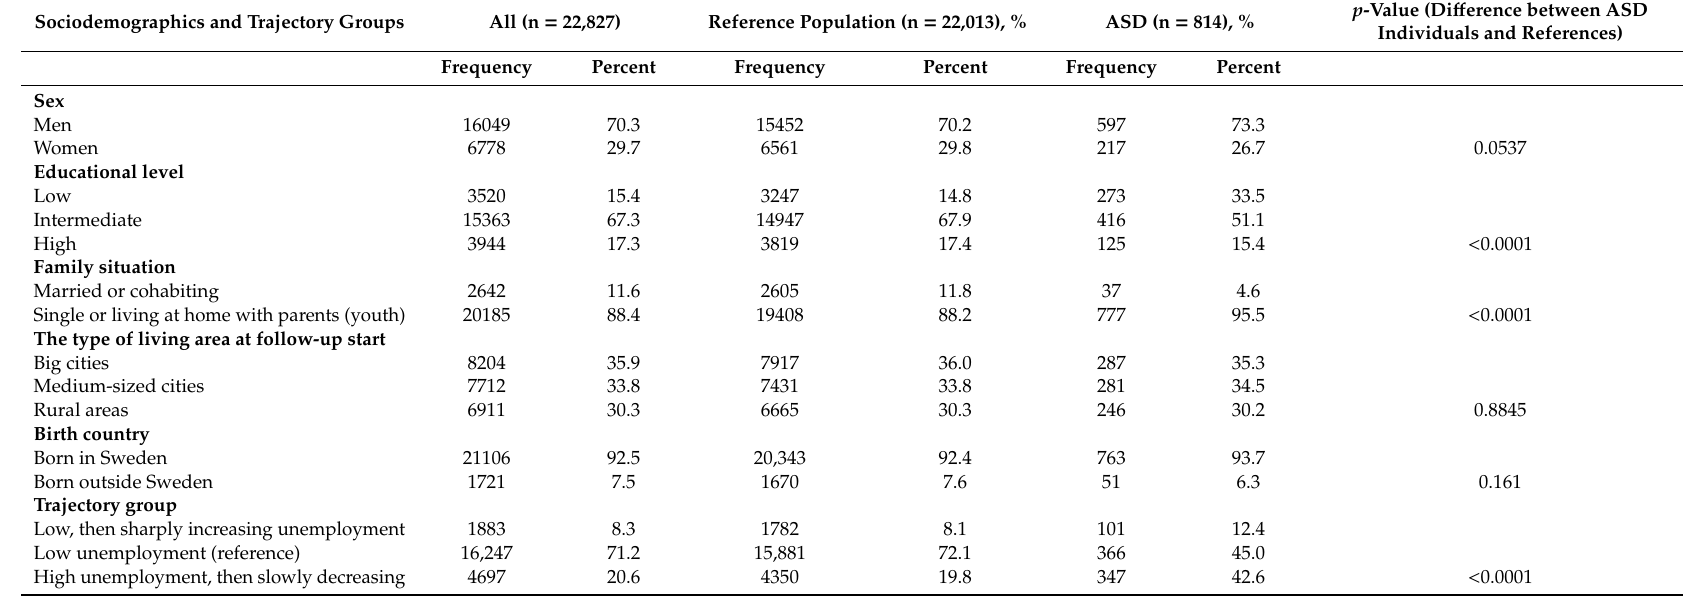
Table 1. Descriptive characteristics of cohort members, and by people with autism spectrum disorder (ASD) and in the reference population. Sociodemographics and Trajectory Groups All (n =